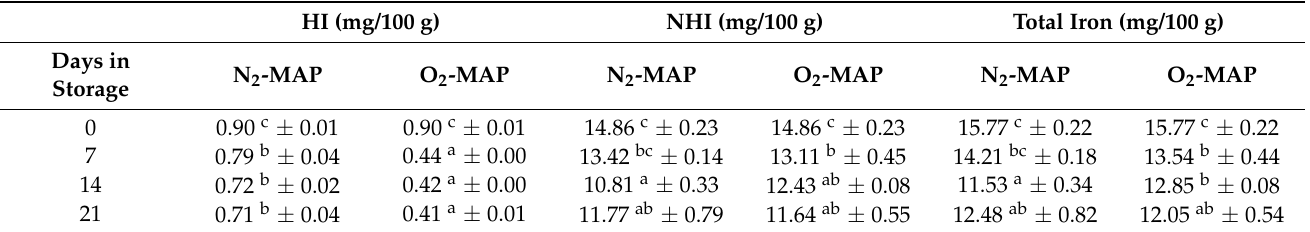
Table 7. Effect of time in storage and MAP on the different forms of iron measured in the 3D-printed products form